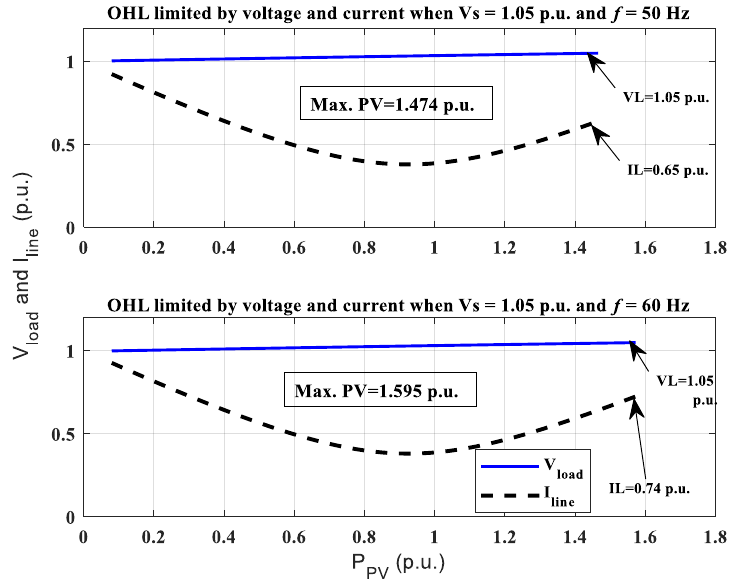
Figure 11. Effect of system frequency on maximum PV penetration limit for the OHL (Substation voltage V S = 1.05 p.u.). Table 8. Effect of system frequency on maximum PV penetration limit for the UGC.